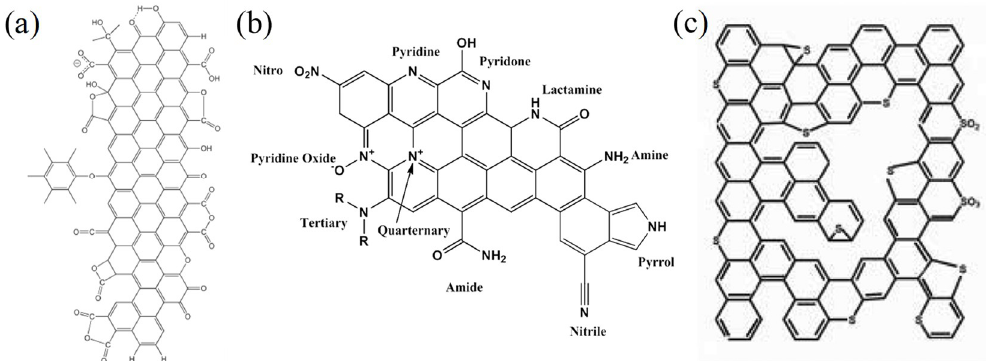
Figure 2. Examples for ( a ) oxygen-, ( b ) nitrogen-, and ( c ) sulfur-containing structure motives in nanoporous carbon-based materials. ( a ) reproduced from [21], with permission from Wiley, 2008; ( b ) reproduced from [30], with permission from RSC Publishing, 2015; ( c ) reproduced from [31], with permission from American Chemical Society, 2012.